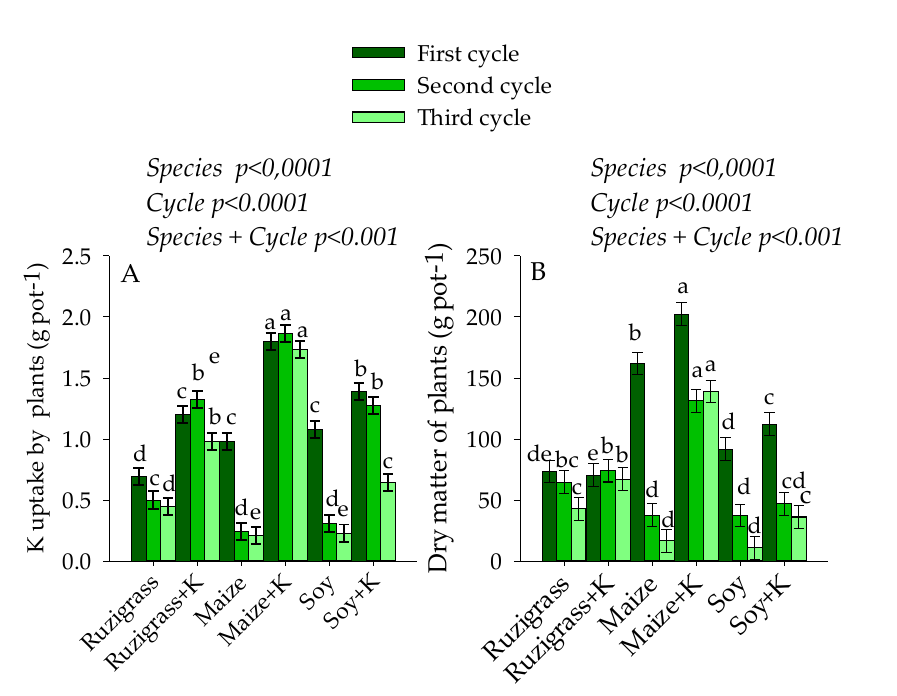
Figure 1. K uptake ( A ) and plant dry matter production ( B ) in three successive ruzigrass, maize, and soybean crop growth cycles, with and without application of K fertilizer. The absence of overlap by vertical bars shows significant differences among cycles in the same crop and fertility treatment. Lowercase letters indicate differences among species when crop cycle and fertility treatment were held constant (LSD, p ≤ 0.05).